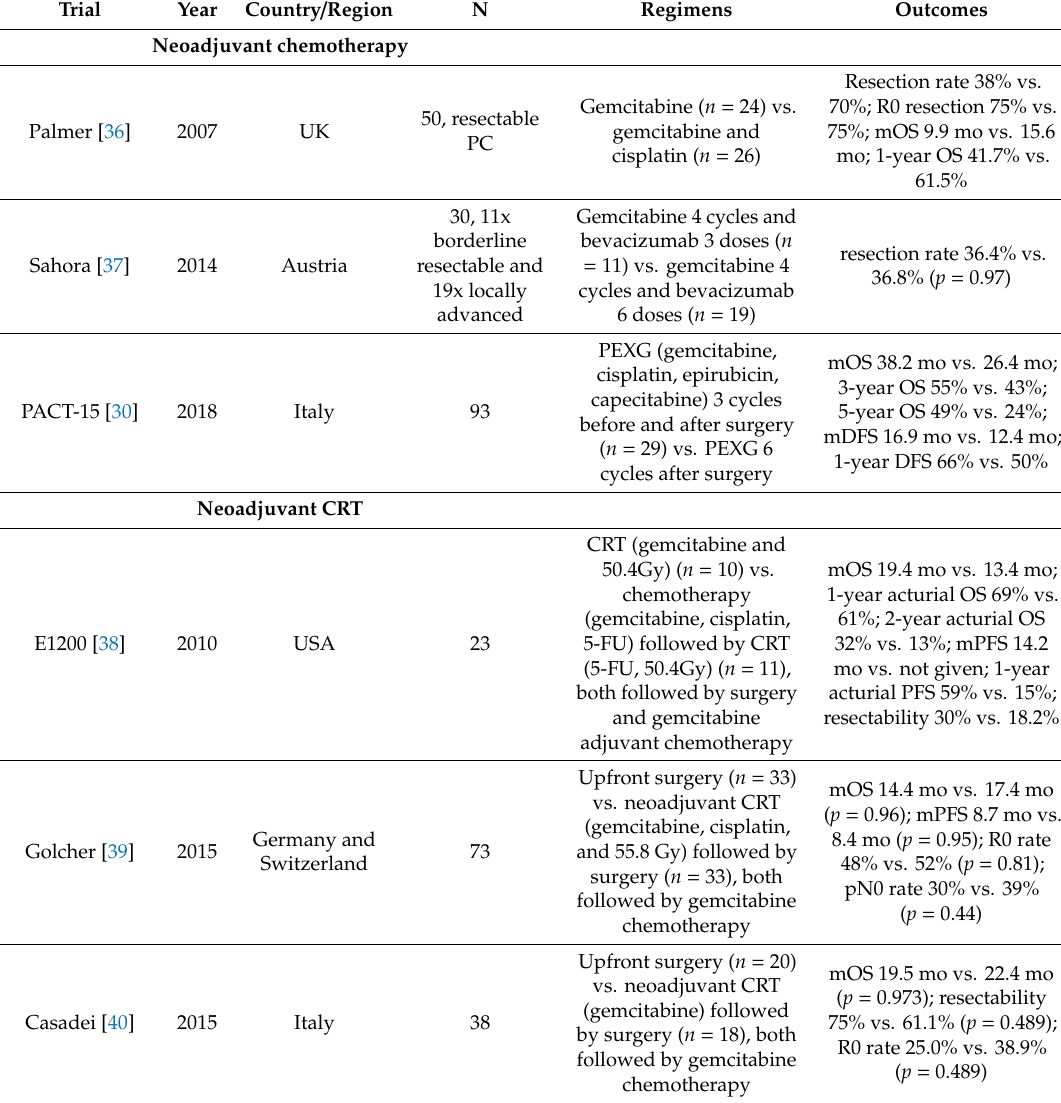
Table 2. Summary of randomized controlled trials concerning neoadjuvant chemo(radio-)therapy in patients with pancreatic